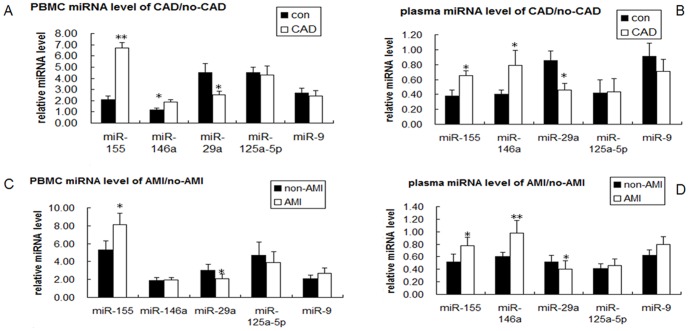
Relative expression levels of specified miRNAs in PBMCs and plasma from CAD patients.PBMC (A) and plasma (B) were collected from patients with angina-like symptoms but safely excluded by coronary angiogram (n = 22), and from CAD patients who had at least one diseased vessel (n = 65). (C) and (D) PBMC and plasma were collected from patients suffering from AMI (n = 30), and patients with coronary heart disease but without AMI (n = 35). Total RNA was isolated, reverse-transcribed, and subjected to real-time PCR analysis. Data are represented as mean ± SD; *P<0.05 and ** P<0.01.